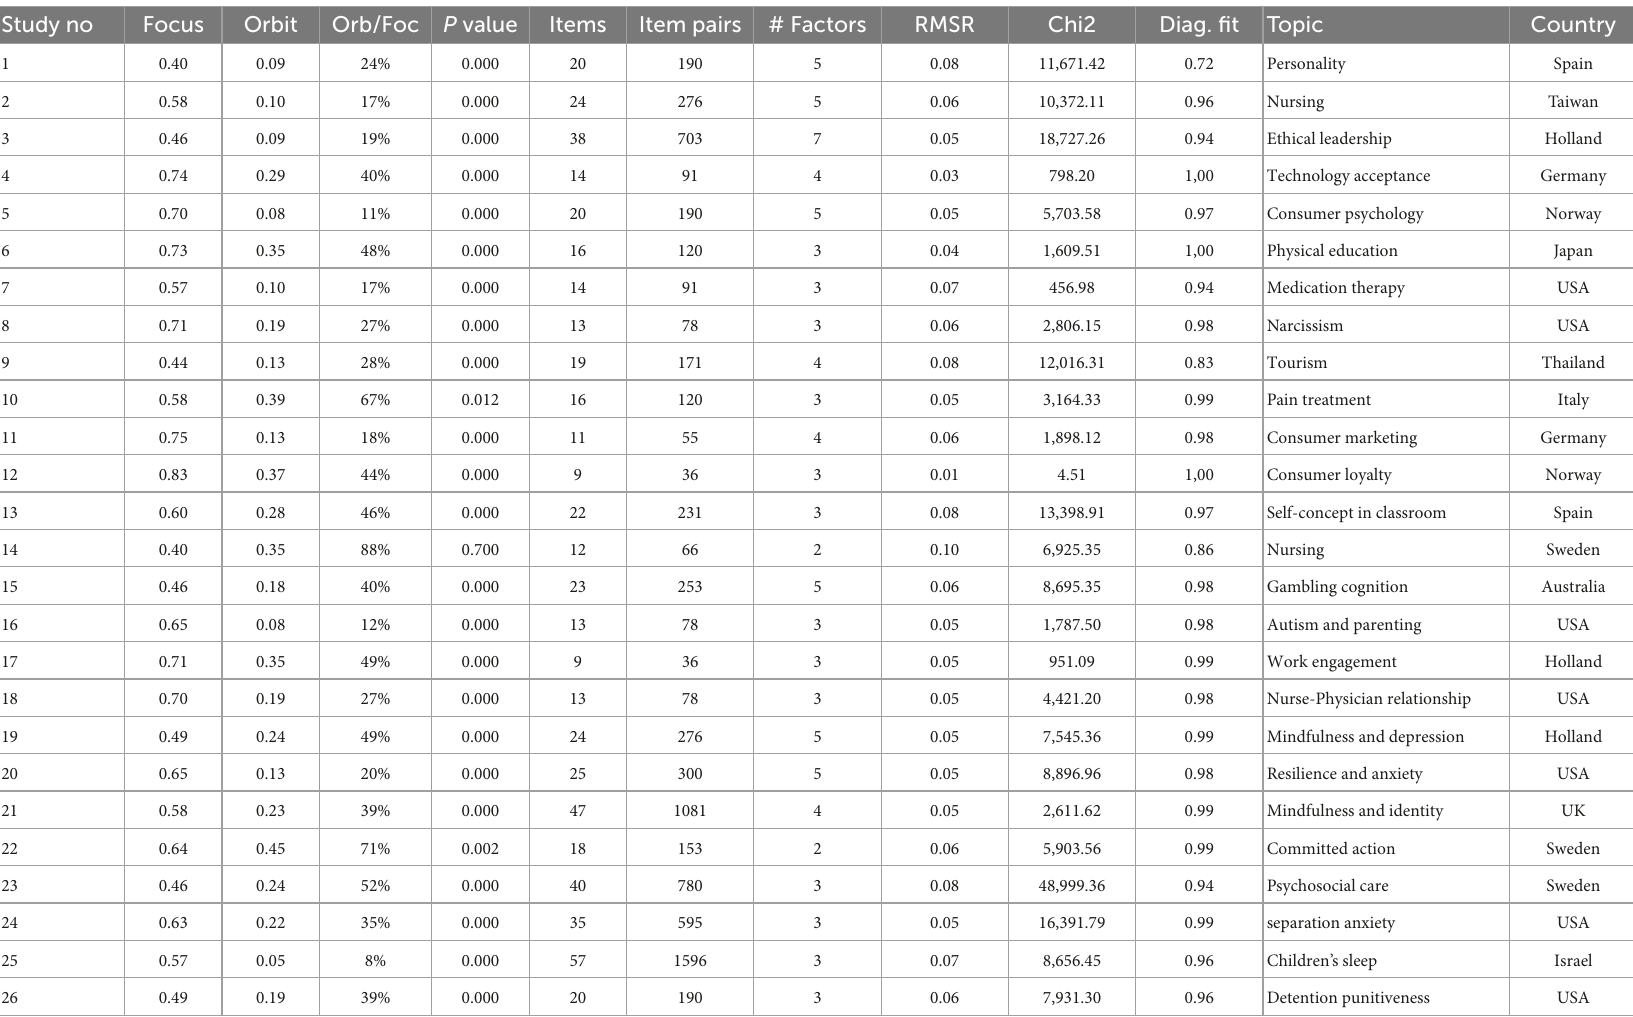
TABLE 3 Semantically replicated factor structures with fit statistics, topics and countries of